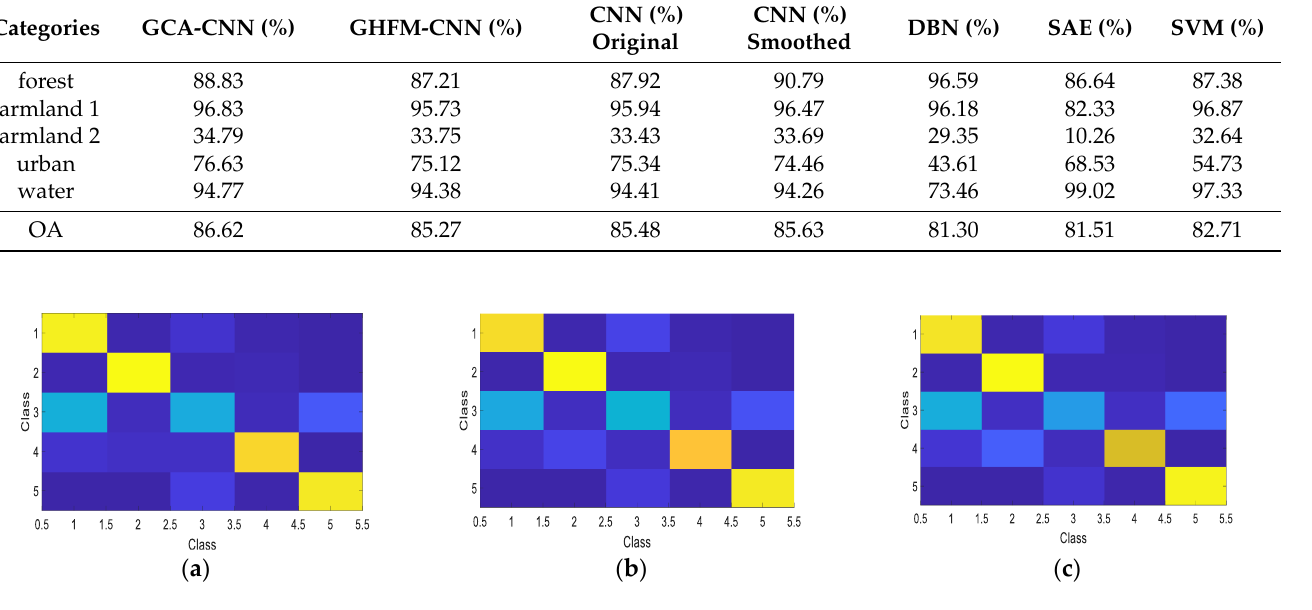
Figure 14. The confusion matrices of ( a ) GCA-CNN, ( b ) GHFM-CNN and the ( c ) OI-CNN.